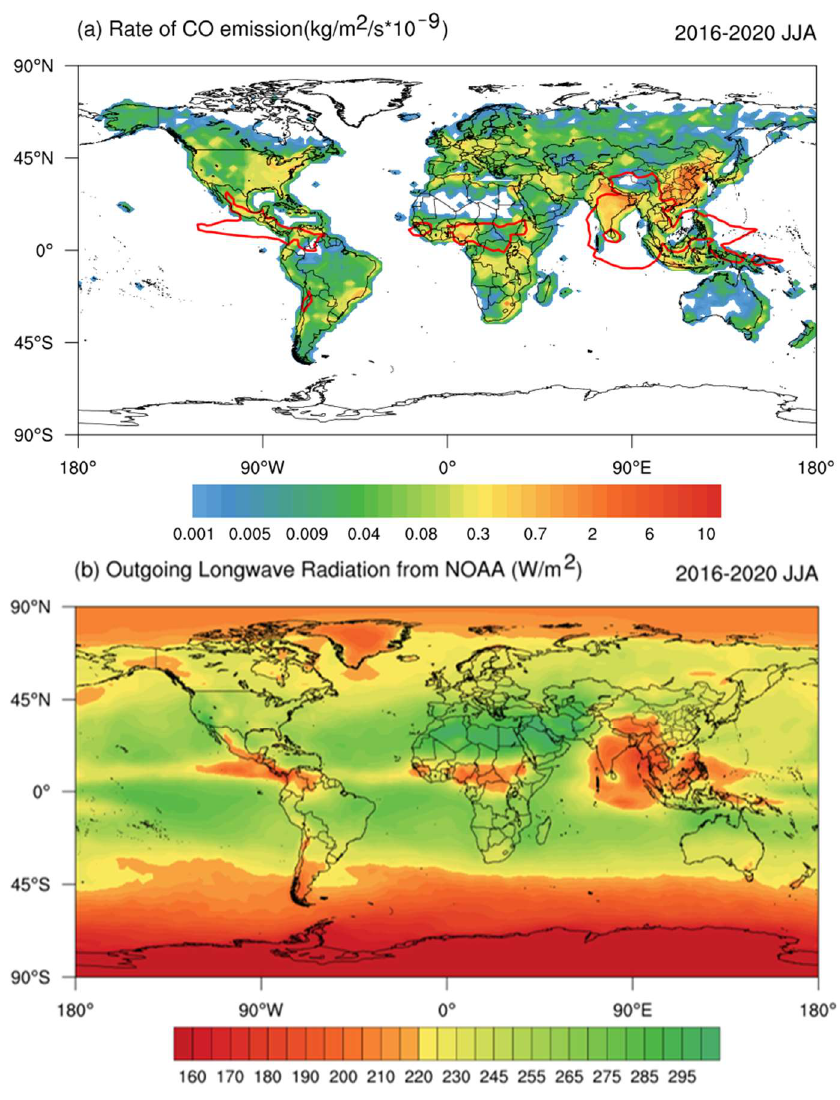
Figure 1. Five-year average results of surface emission rate ( a ) and OLR ( b ) in summer (June, July and August) from 2016–2020. The red line represents the area where OLR ≤ 220 W/m 2 .